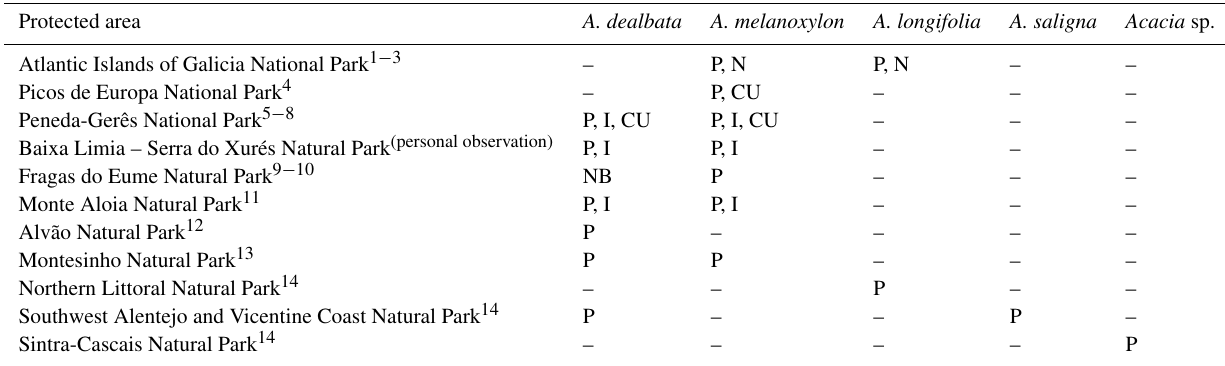
Table 3. Protected areas in western Iberia invaded by Australian Acacia species. Key: N, naturalized; P, present; I, increasing; CU, control unsuccessfully attempted; NB, nearby